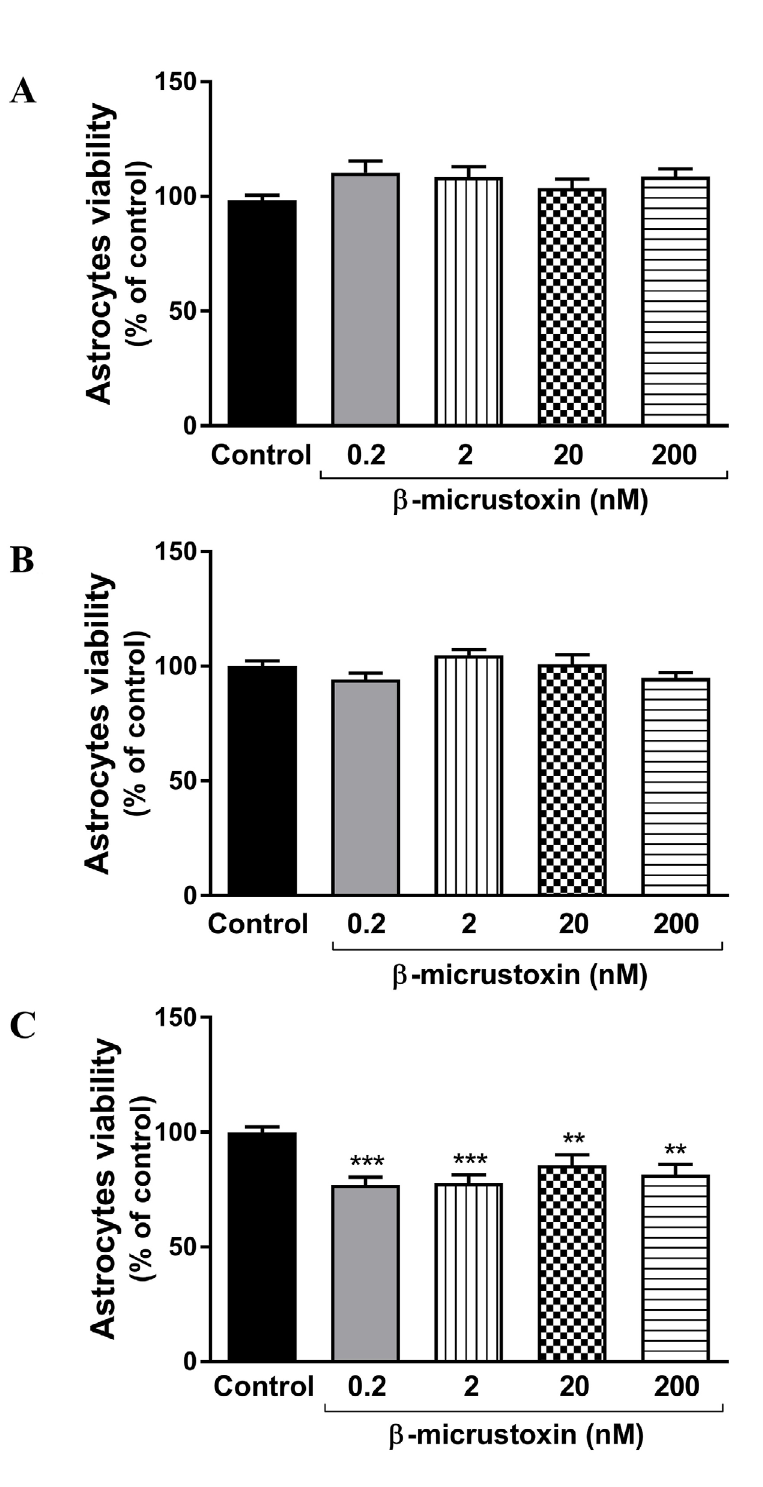
Figure 3. Viability of cultured astrocytes incubated in the absence (control) or presence of β-micrustoxin (0.2, 2, 20, 200 nM) for (A) 3 h, (B) 12 h, (C) 24 h. N = 20/group. One-way ANOVA followed by Bonferroni post-hoc test: **p < 0.01; ***p < 0.001 vs. control, three full experimental